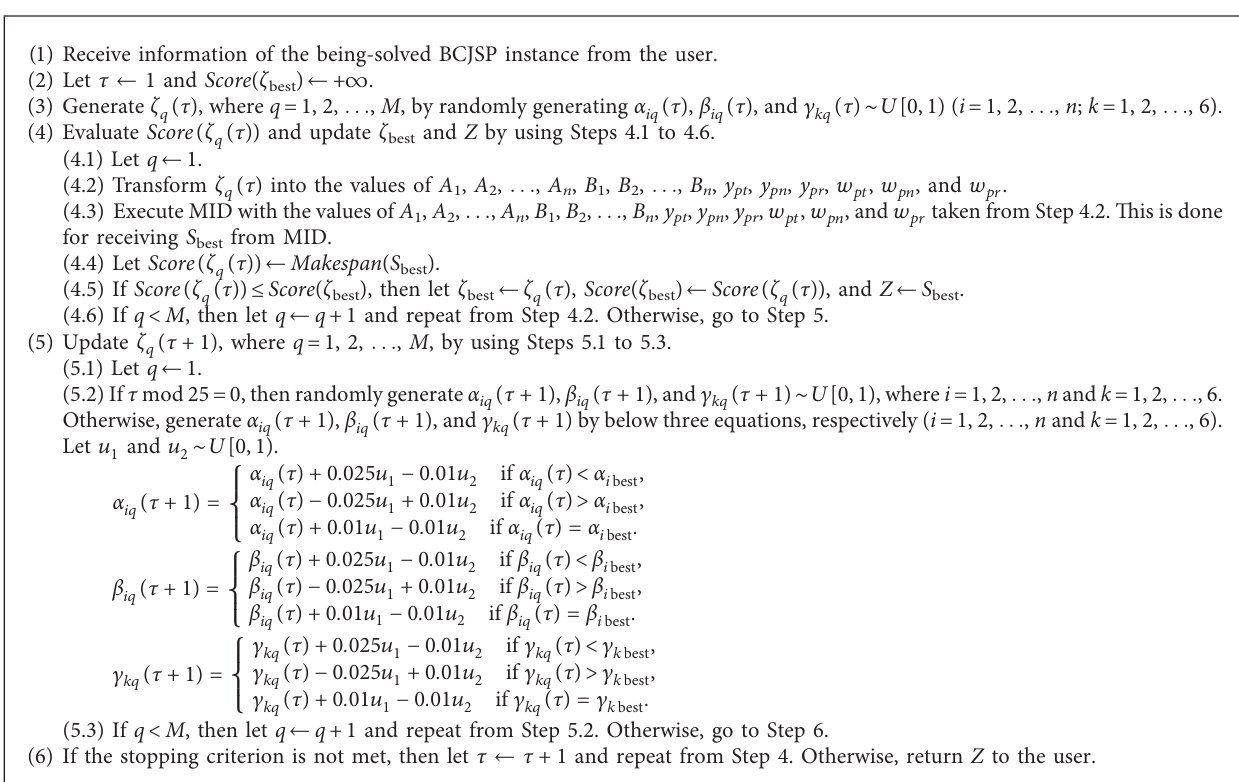
Algorithm 3 by removing c kq ( τ ) from Step 3; removing y y , y , w pt , w pn and w pr from Steps 4.2 and 4.3; pn pr